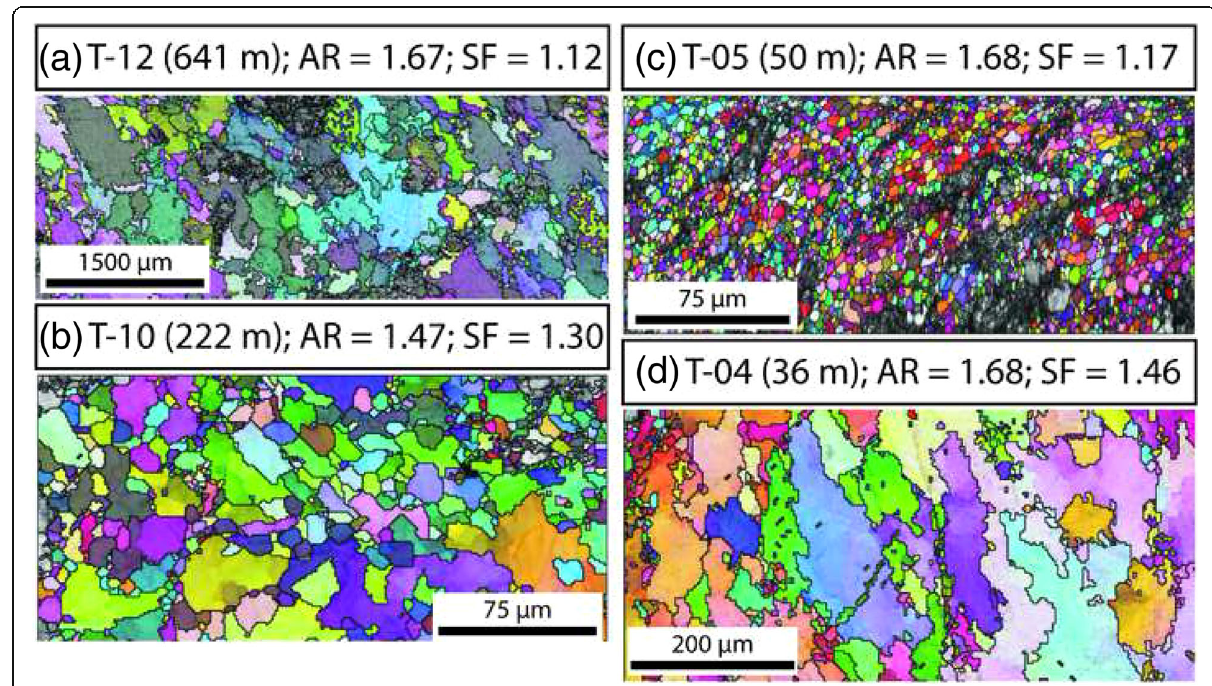
Fig. 7 Variation in quartz microstructure (EBSD inverse pole figure maps) with distance from the MTL in the Tsukide area ( a – d ). Colouring indicates the crystallographic orientation of quartz relative to the horizontal axis. Grains other than quartz are coloured grey. Grain boundaries (based on a 10° segmentation angle) are indicated by thin black